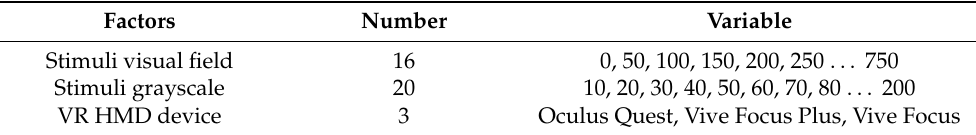
Table 1. Parameters of the